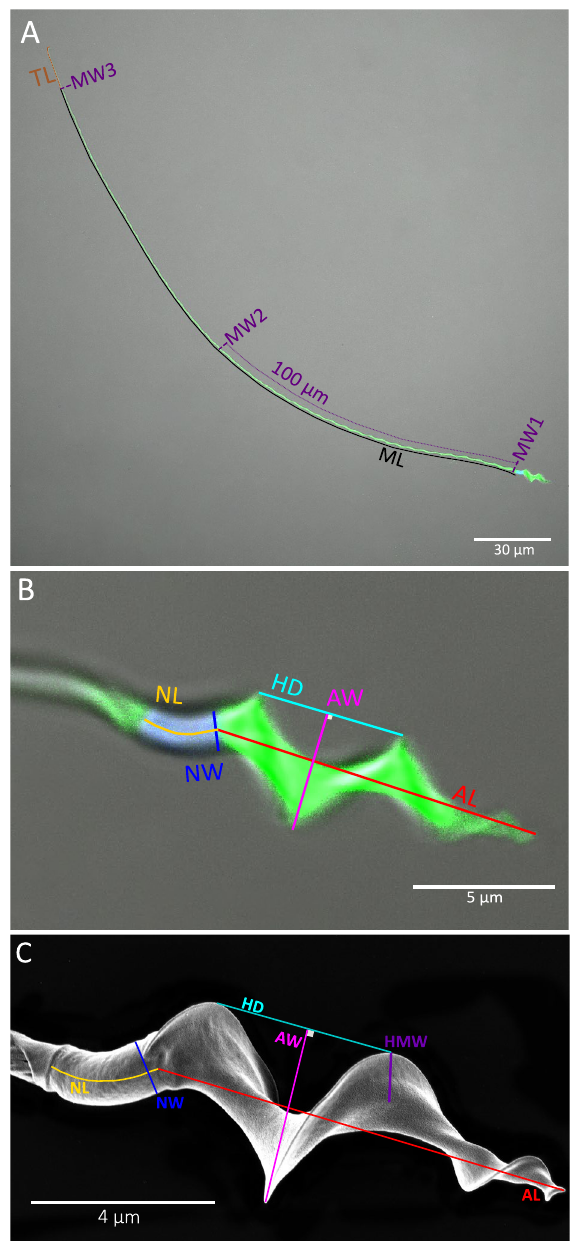
Figure 2. Sperm morphological traits measured on photos from confocal ( A , B ) and scanning electron microscope ( C ). On photos from confocal microscope, the flagellum and the acrosome are labelled using MitoTracker (green) and the nucleus by DAPI (blue). The following traits were measured on the flagellum: midpiece length (ML), midpiece width (MW1, MW2, MW3), and tail length (TL). On the sperm head we measured: acrosome length (AL), acrosome width (AW), nucleus length (NL), nucleus width (NW), helix distance (HD), and helical membrane width (HMW). Displayed images are of representative common nightingale sperm with the background modified to remove